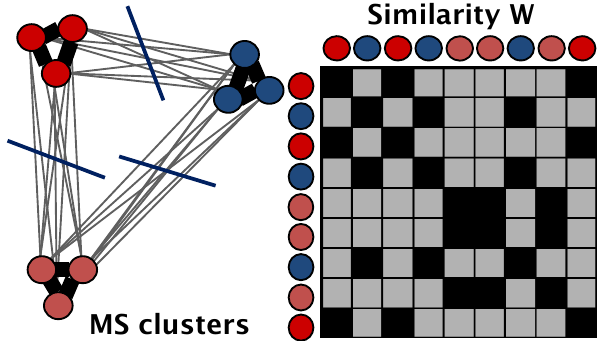
Figure 5 Schematic representation of graph-based segmentation